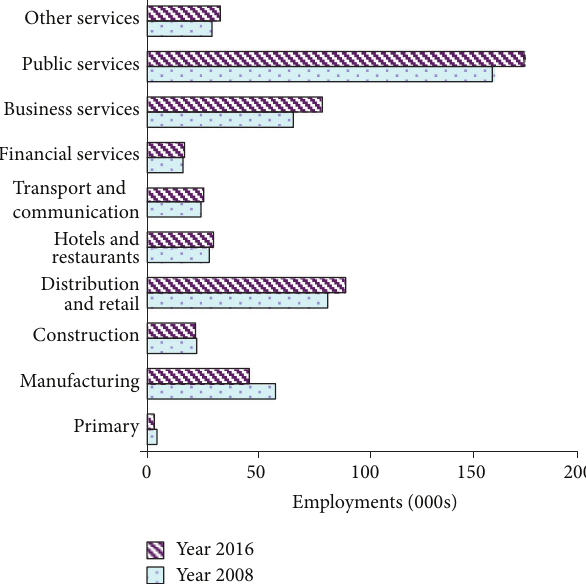
Figure 2: Anticipated employment by SIC (UK Standard Industrial Classification of Economic Activities) in the region of Tyne and Wear, 2008–2016. Source: